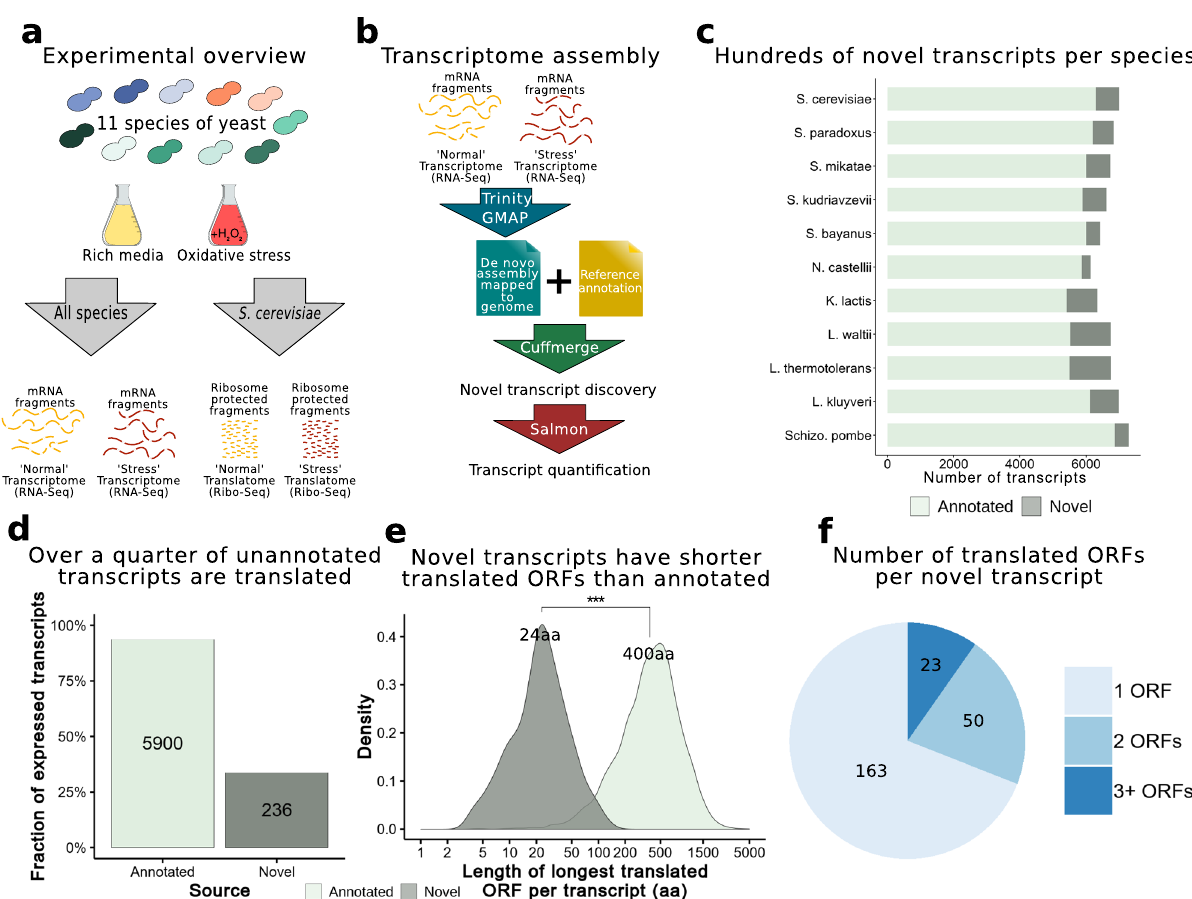
Fig. 1 Identi fi cation of novel, non-annotated, transcripts and proteins. a Experimental overview of our study. We grew 11 species of yeast in two conditions (rich media and oxidative stress), then performed RNA-Seq on all 22 samples. We also performed Ribo-Seq for S. cerevisiae . b Transcriptome assembly. We generated a combined transcriptome assembly combining annotated genes together with the subset de novo assembled transcripts not present in the annotations. Subsequently, we quanti fi ed the expression of all transcripts in the two conditions. c Transcriptomes per species. We obtained hundreds of novel, non-annotated, transcripts, for each species. d Prediction of novel translated ORFs. Using the presence of translation signatures in the ribosome pro fi ling data we predicted novel translated ORFs in S. cerevisiae . We found 236 non-annotated transcripts likely to encode novel, not yet characterized, proteins. e Size of novel and annotated proteins. Novel proteins identi fi ed by ribosome pro fi ling were signi fi cantly smaller than annotated proteins (two-sided Wilcoxon test, p -value < 2.2e-16). Computation of protein length was based on the longest coding sequence per transcript; values in black are the medians. f Number of ORFs per transcript. A sizable proportion of the novel transcripts were predicted to encode for more than one ORF. Source data are provided as a Source Data fi